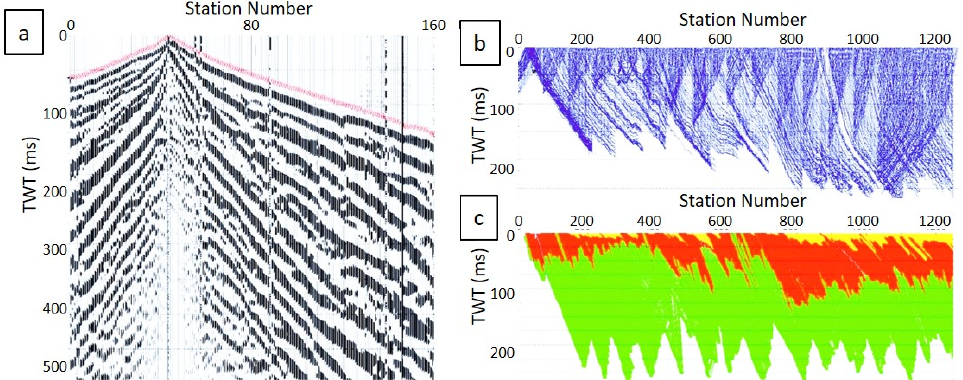
Figure 6. The fundamental inputs for resolving the P-wave velocity subsurface distribution. ( a ) Example of the first-arrival times picked in the shot viewer (red crosses); ( b ) the space-time graphs of all picked first-arrivals; and ( c ) the first-arrival time is picked as a function of the independent variables CMPx (station) and the CMP constant offset. Ray paths are shown with a velocity reduction of 5000 m/s.